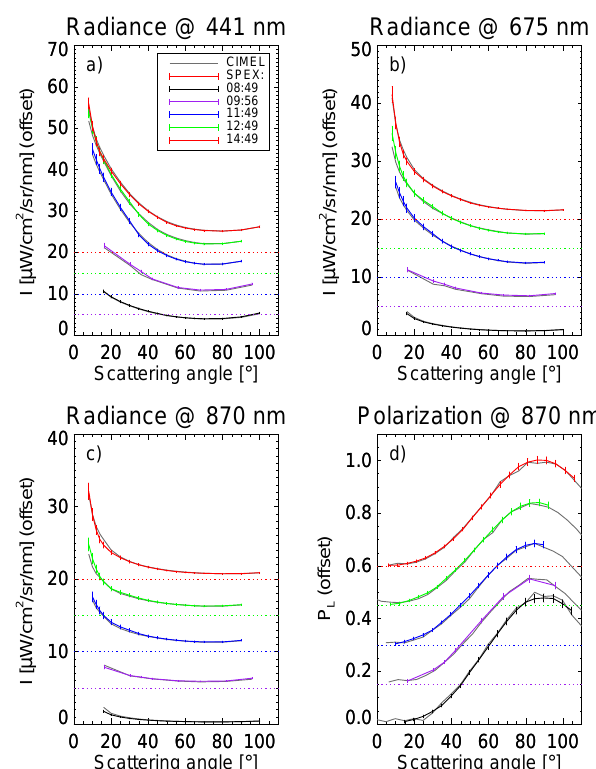
Figure 4. Comparison between groundSPEX (colored lines with er- ror bars) and the co-located CIMEL sun photometer (grey lines), for clear-sky radiance at a) 441 nm, b) 675 nm, and c) 870 nm, and d) polarization at 870 nm, as a function of scattering angle in the prin- cipal plane. The instruments measured simultaneously at five times (see legend [UTC]) on July 9, 2013, at CESAR Observatory. The different sets are offset for visibility, with the offsets indicated by the dotted lines.